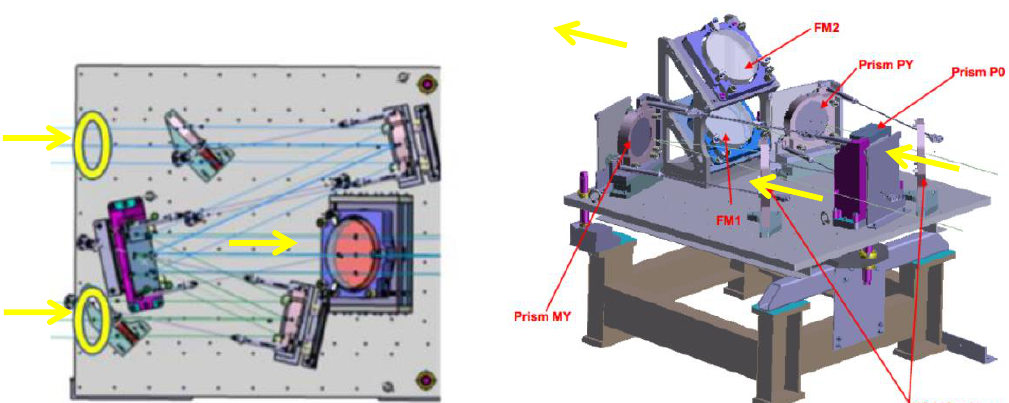
Figure 7. FPA part A, OGSE periscope setup for TxA beam collection into COL70. Reproduced with permission of Airbus ©.